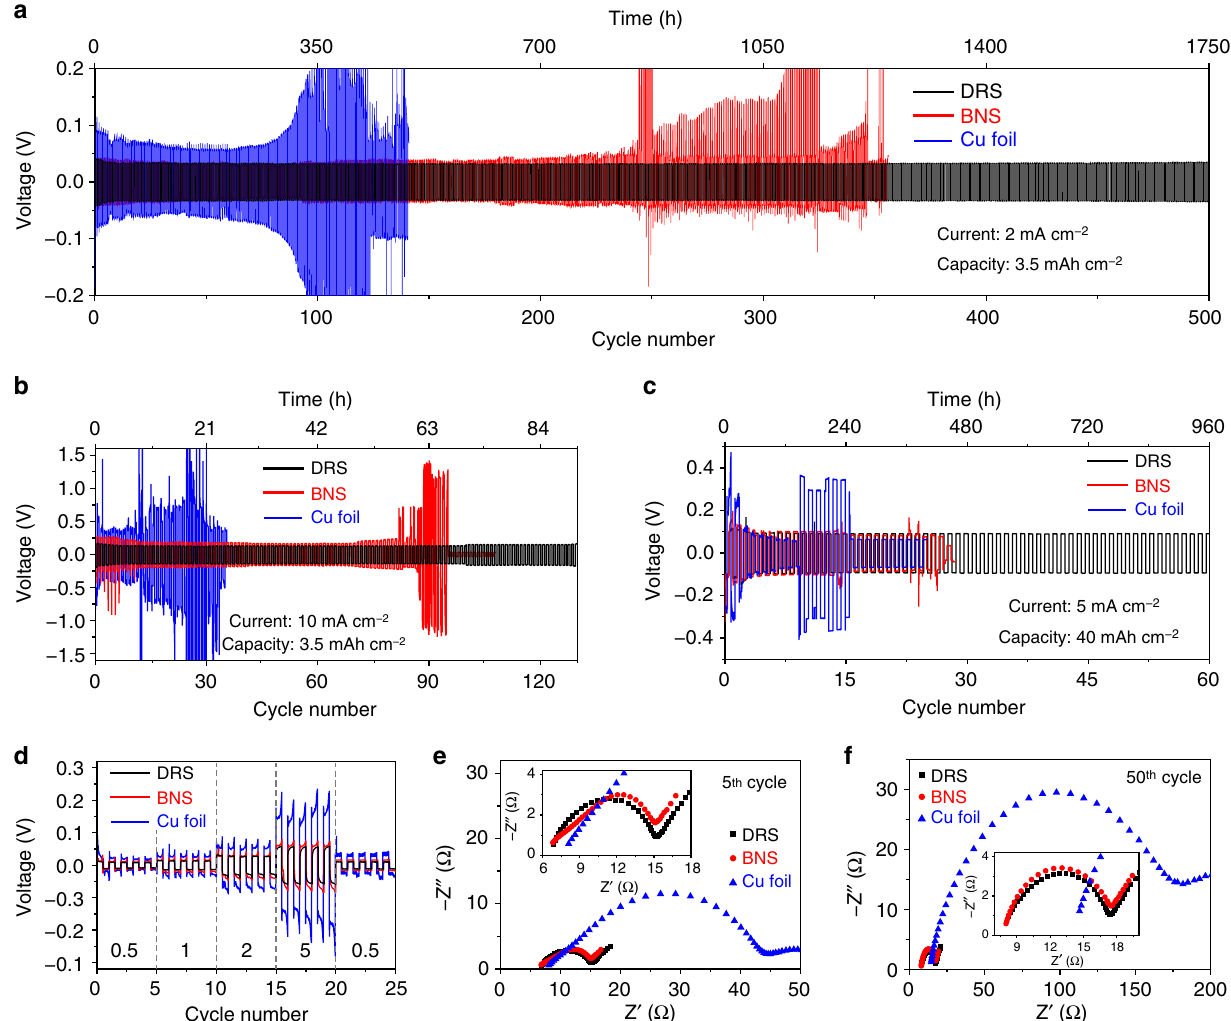
Fig. 4 Electrochemical properties of symmetric cells during cycling at high rates and capacities. Voltage pro fi les of Li plating/stripping with a capacity of 3.5 mAh cm − 2 at different current densities of a 2 mAcm − 2 and b 10 mAcm − 2 . c Voltage pro fi les at an ultrahigh capacity of 40 mAh cm − 2 at 5 mA cm − 2 . d Rate properties of cells with a capacity of 2 mAh cm − 2 (the unit for each current is mA cm − 2 ). Nyquist plots of the three cells at the e 5 th and f 50 th cycles,